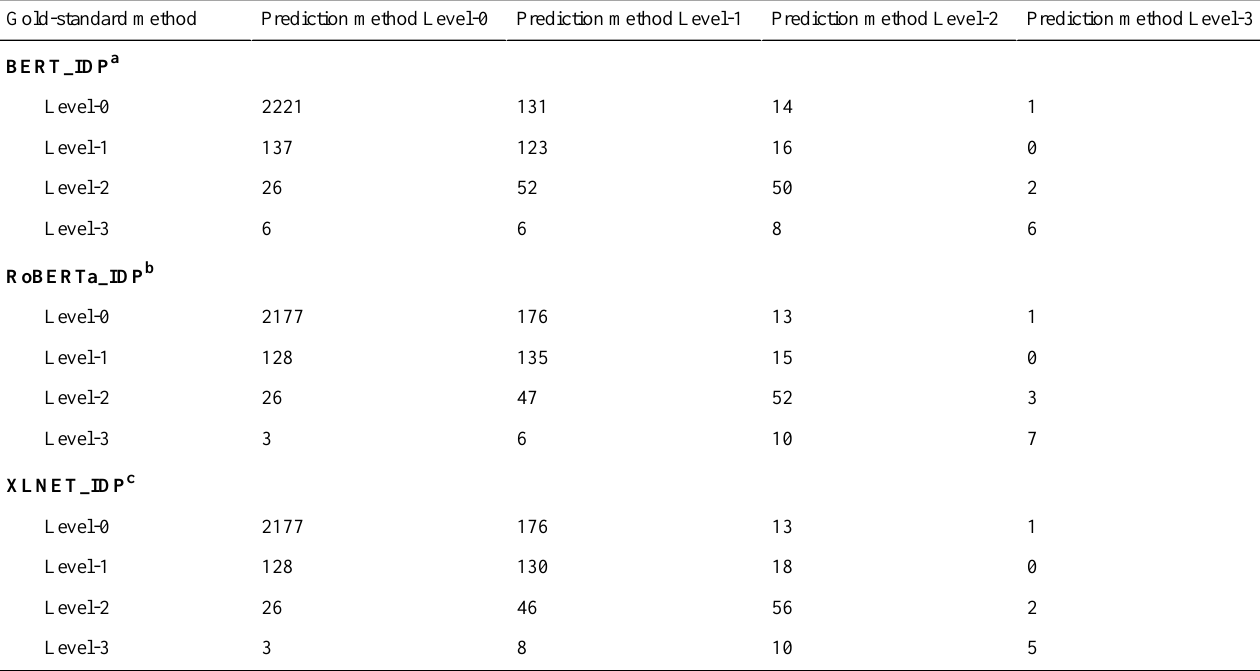
Table 7. Confusion matrix of the deep-learning methods with in-domain